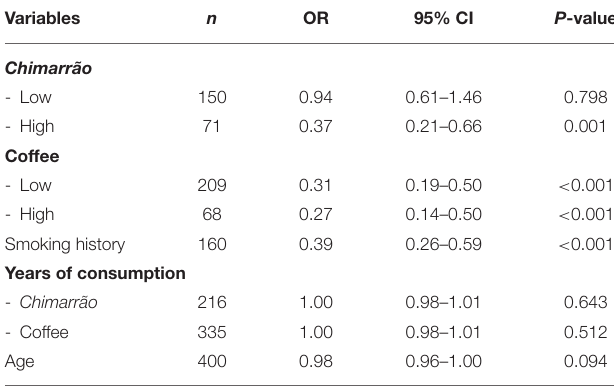
TABLE 2 | Univariate analysis of chimarrão and coffee consumption, smoking history, years of consumption, and age ( chimarrão low consumption < 6